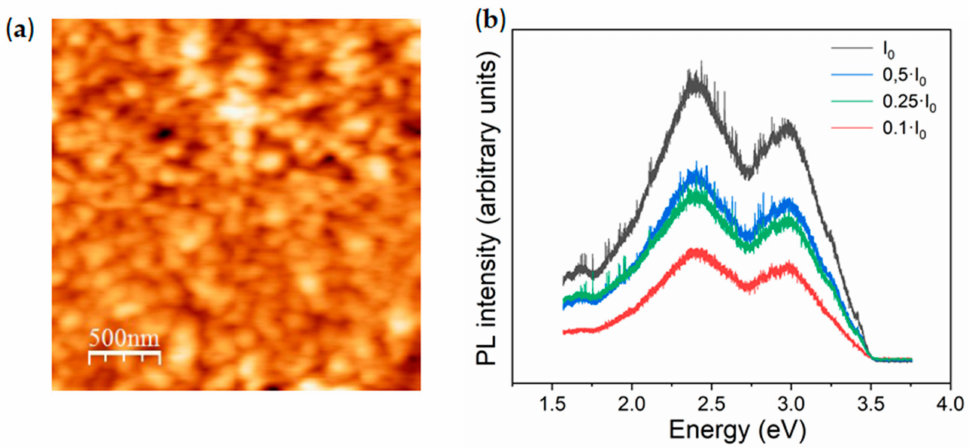
Figure 3. ( a )Atomicforcemicroscopy(AFM)image; ( b )PLspectraacquiredwiththeUVlaser( λ = 325nm) and variable laser intensity from spin-coated poly(3,4-ethylenedioxythiophene)-poly(styrenesulfonate)